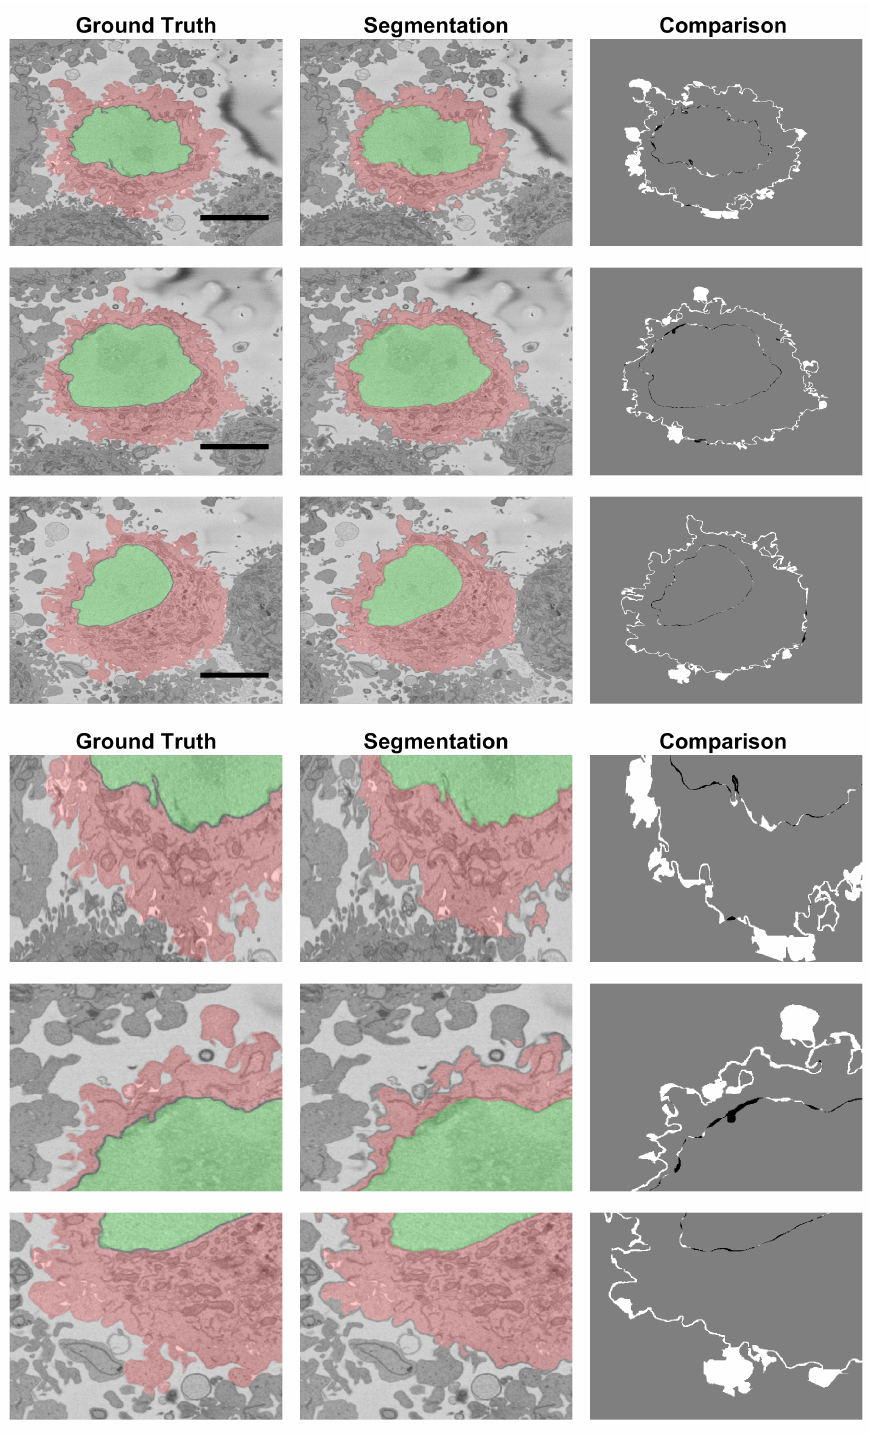
Figure 11. Comparison between the Ground Truth (GT) and the segmentation result obtained from the segmentation algorithm shown in three slices of the stack. The left column illustrates the GT with shades of green for the nucleus and shades of red for the cell. The centre column shows the result of the segmentation algorithm. The right column shows the comparison between the GT and the results with FNs in white, FPs in black and both TPs and TNs in grey. Large white regions correspond to the distinction between neighbouring cells. A 5 µ m scale bar is shown in the GTs on the top, and a magnification is shown